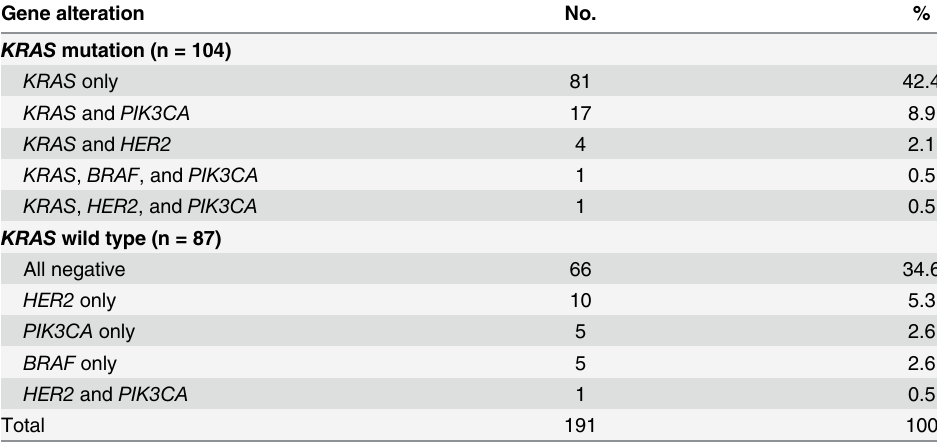
Table 1. The frequencies of genetic alterations for the entire cohort of 191 advanced CRC patients. Gene alteration No. % KRAS mutation (n =